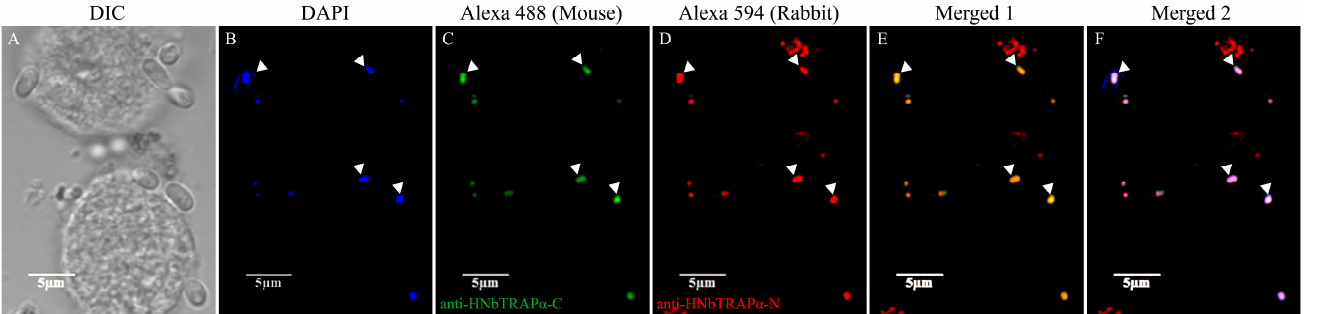
Figure 5. Indirect immunofluorescent assay of HNbTRAP α in mature spores. Pictures A~F were BmE cells infected by N. bombycis and many mature spores were released. HNbTRAP α -C mouse antiserum and HNbTRAP α -N rabbit antiserum were used as the primary antibody, respectively, and coupled with goat anti-mouse Alexa 488 or goat anti-rabbit, respectively. HNbTRAP α -C antiserum, as well as HNbTRAP α -N antiserum, recognized the nucleus region of the mature spores and their signals merged completely (white arrowhead).